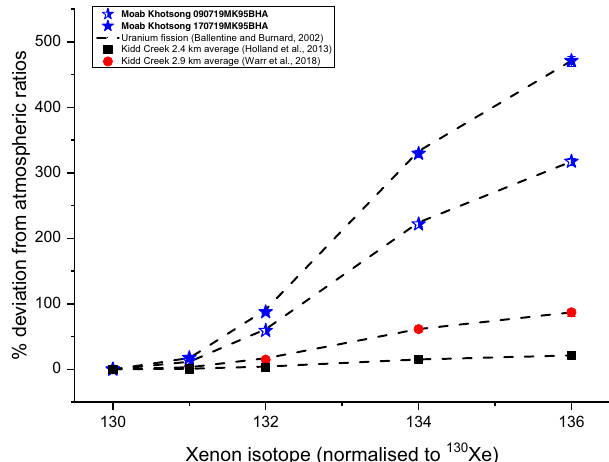
0.0 Fig. 1 Neon isotope data. Neon signatures con fi rm that fl uids sampled at Moab Khotsong (blue stars) are the result of radiogenic (nucleogenic) production in the crust added to an initial, Air-Saturated Water (ASW) component recharged from the surface, but no discernible mantle contribution. These data are consistent with the elevated crustal 21 Ne production observed to date only in samples collected from Precambrian cratons, e.g. Kidd Creek 2,14 (Canadian Shield), fracture fl uids from Driefontein, Evander, Kloof, and Mponeng mines in the Witwatersrand Basin 17 (demonstrated here by the red triangles and dashed red line reproduced from Lippmann-Pipke et al. 18 ), and fl uid inclusions from both the St. Ives Gold fi eld in the Yilgarn Craton 33 (grey diamonds), and the Mt. Isa inlier (green triangles) 34 . Prior to the discovery of these distinctive radiogenic 21 Ne signatures, radiogenic neon addition to ASW in average continental crust globally fell along the lower trend represented here by the solid black line. Published data from Kidd Creek fracture fl uids 2,14 are plotted for context (black squares and red circles). Sample 090719MK95BHA (half-shaded star) reveals a lower radiogenic excess for all noble gases and is consistent with addition of a minor air component introduced during sampling (see Methods). Error bars represent analytical uncertainty of 1 σ and are typically smaller than the plotted symbols.